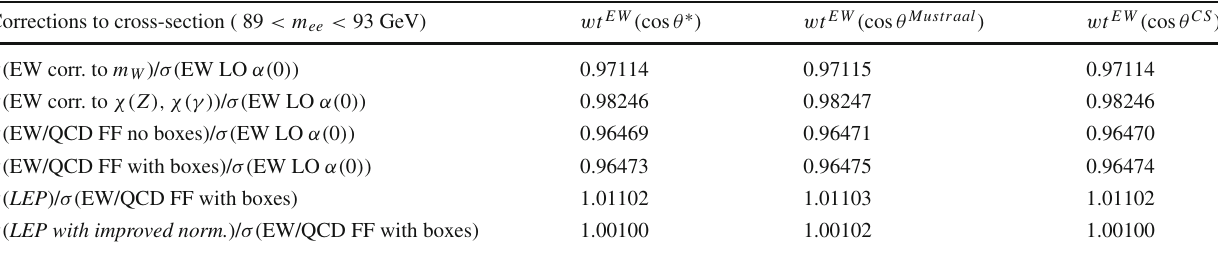
Table 4 EW corrections for cross-sections integrated over the mass window around Z -pole; 89 < m ee < 93 GeV. The EW weight is calculated with cos θ ∗ , cos θ Mustraal or cos θ CS